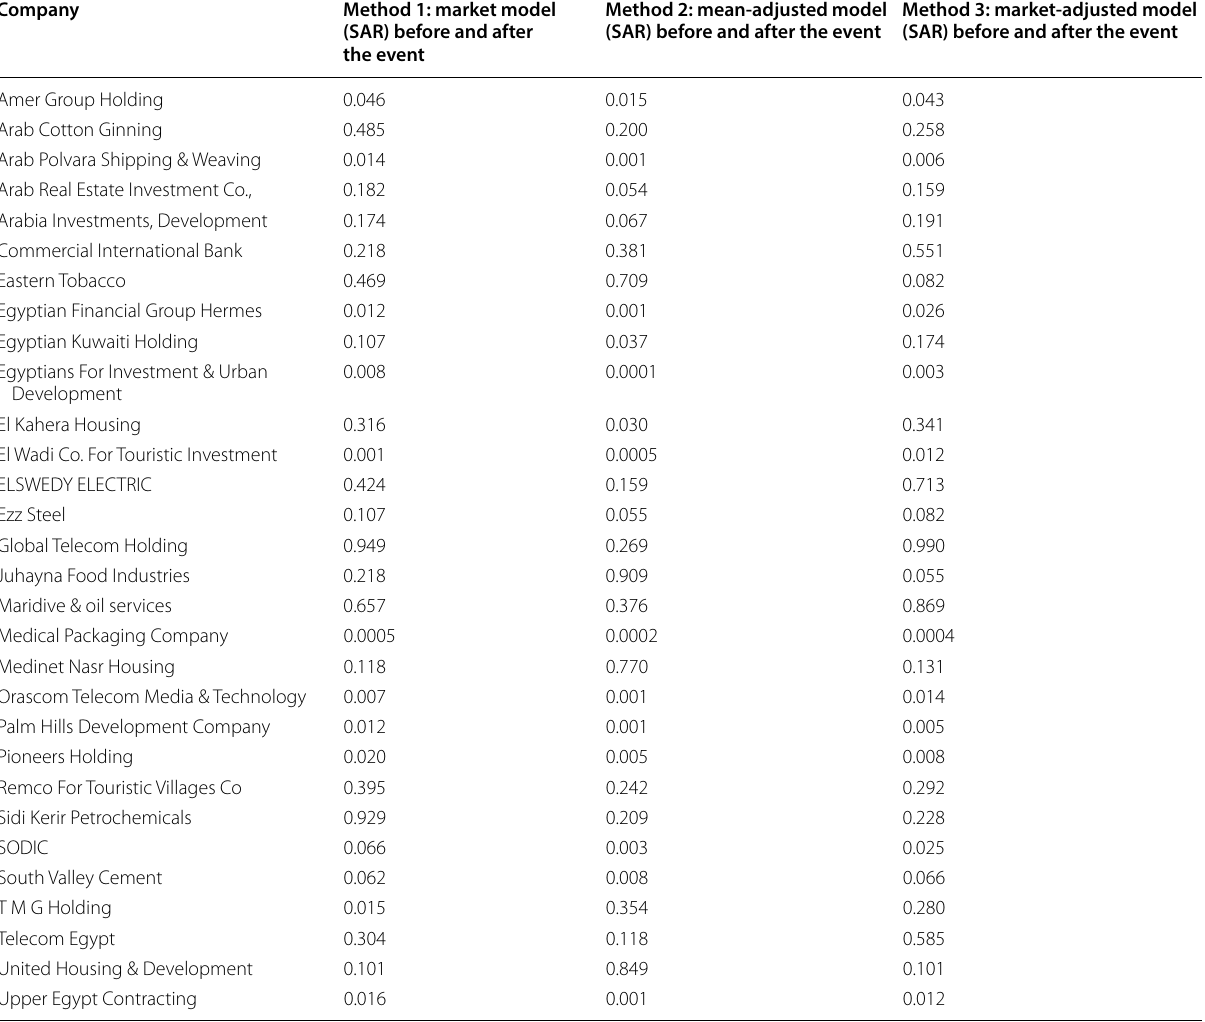
Table 1 Wilcoxon rank-sum test (asymptotic significance at two tails) Company Method 1: market model (SAR) before and